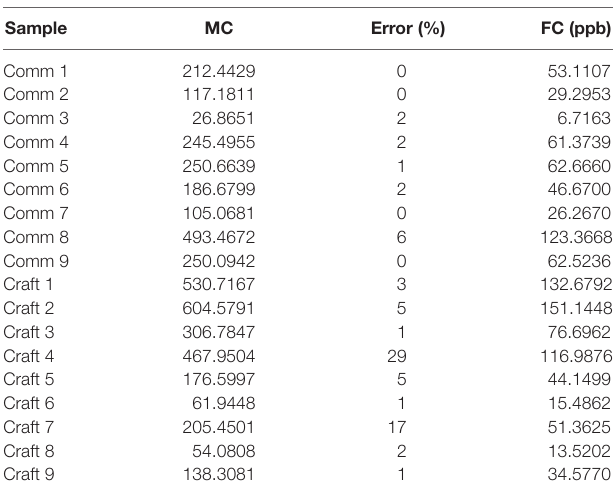
TaBle 3 | Mean concentration (MC, n = 3), absolute error of the measurements ( n = 3), and final concentration (FC) of ethyl carbamate in the tested cachaça samples [commercial (Comm) and